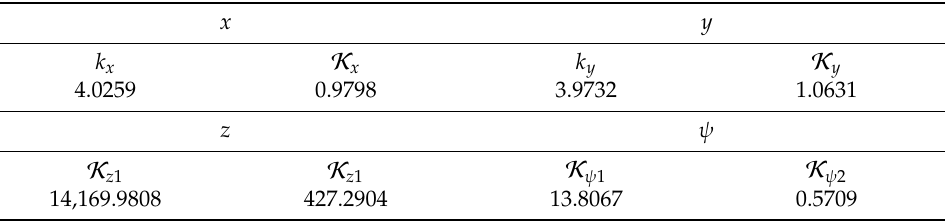
Table 7. Consensus controller parameters.